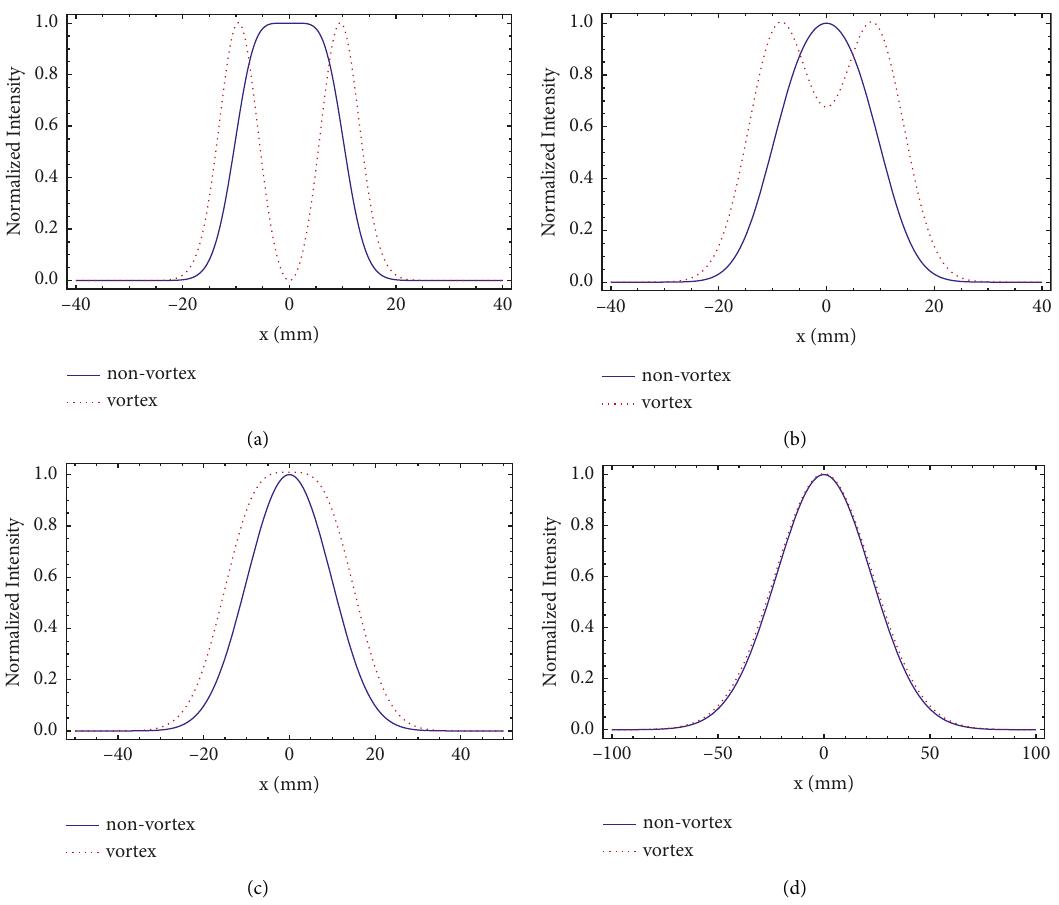
Figure 10: The normalized intensity distribution of the partially coherent circular FT vortex hollow beam and FT nonvortex beam in anisotropic turbulent plasma for different values of propagation distances: (a) z